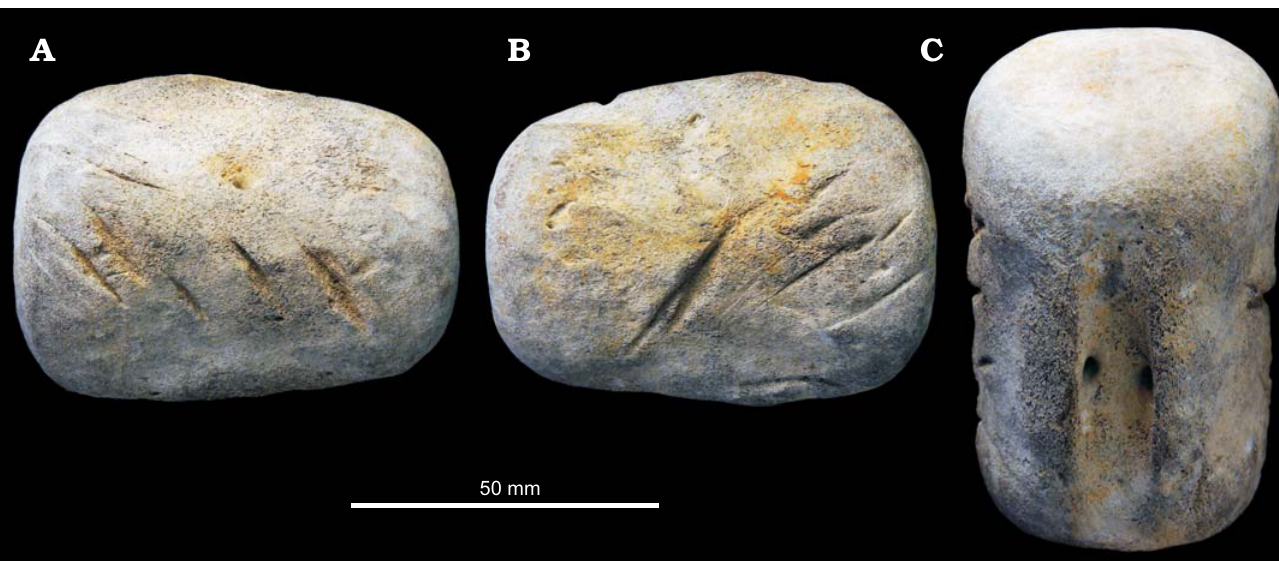
Fig. 2. A Miocene odontocete caudal vertebra, CMM-V-8405 from beach float at Bayfront Park, Calvert Cliffs, Maryland, USA. Peduncular vertebra in left ( A ) and right ( B ) lateral views and anteroventral ( C ) view. Multiple gouges are present on both sides of the vertebra.